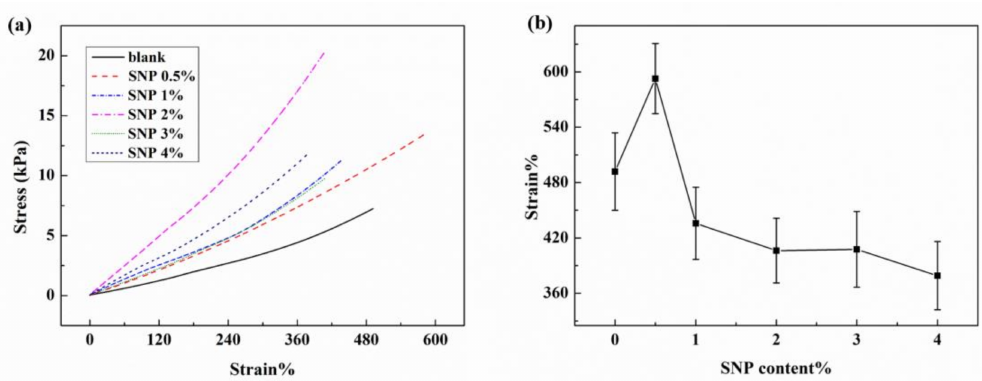
Figure 3. Mechanical properties of ionogels with di ff erent contents of SNPs: ( a ) stress-strain curves of ionogels with di ff erent contents of SNP; ( b ) breaking strain of ionogels with di ff erent contents of